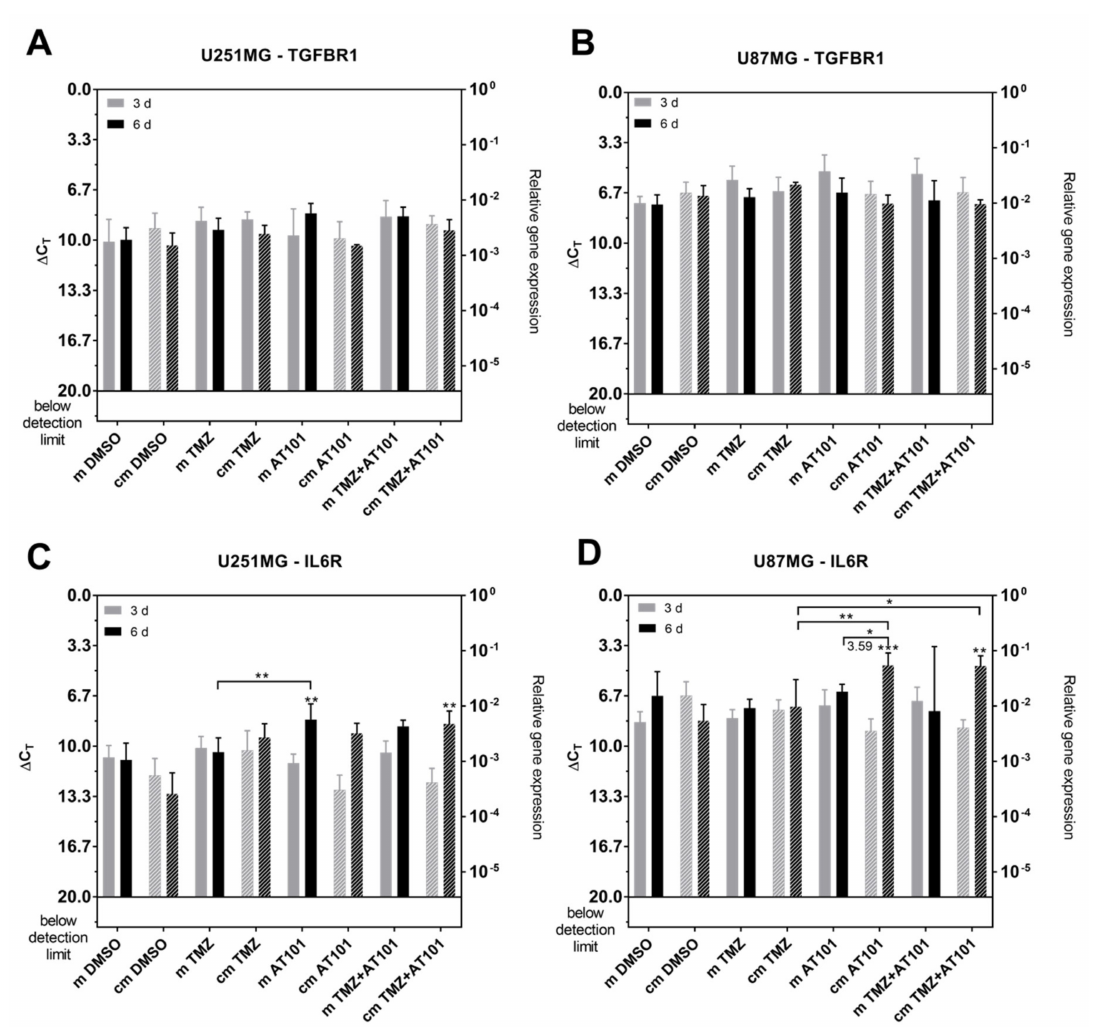
medium. Error bars correspond to the standard deviation.